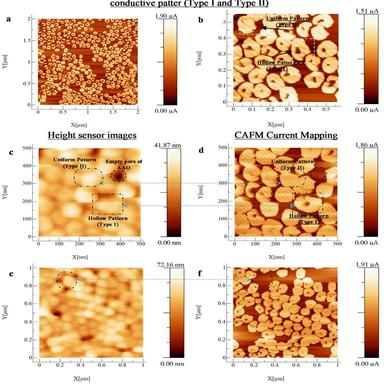
(a) Typical CAFM images of top surface of gold nanorods embeded in porous alumina template using Pt/Ir tip tip with diameter of 10 nm ± 5 nm (b) Higher magnification CAFM current mapping image showing type I and type II conducting patterns (c) AFM contact mode height sensor images of nanorods embedded in the alumina matrix and (d) Conductive pattern of corresponding nanorods again showing both conducting patterns. (e) 1 × 1 µm height sensor image of nanorods and (f) The corresponding conductive pattern illu